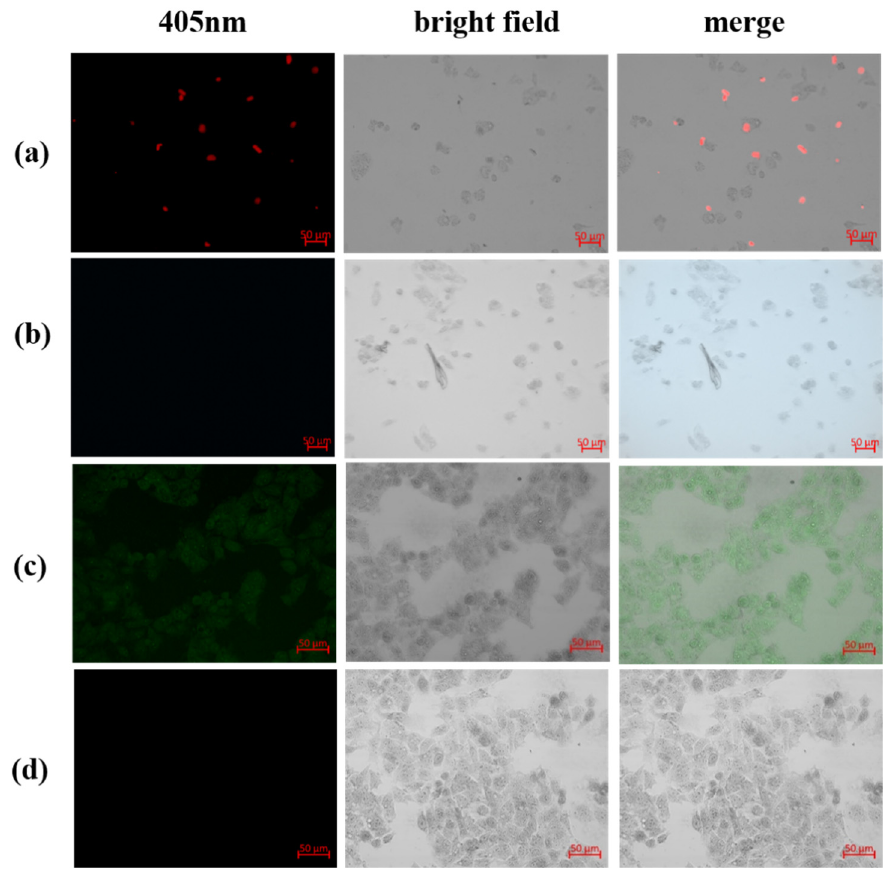
Figure 9. ( a ) Laser scanning confocal fluorescence image of HepG2 cells incubated with ECA nanoparticles and ( b ) ECA-containing cells after adding CPT-11. ( c ) Laser scanning confocal images of HepG2 cells incubated with TCA nanoparticles and, ( d ) TCA-containing cells after addition of CPT-11.